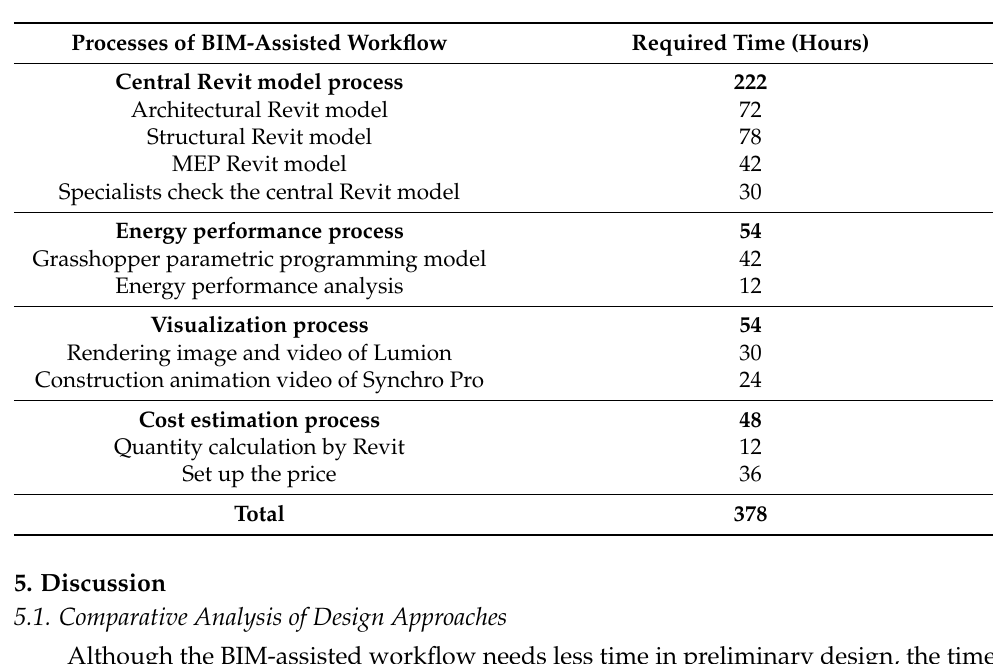
Table 4. Duration results of BIM-assisted workflow simulation.